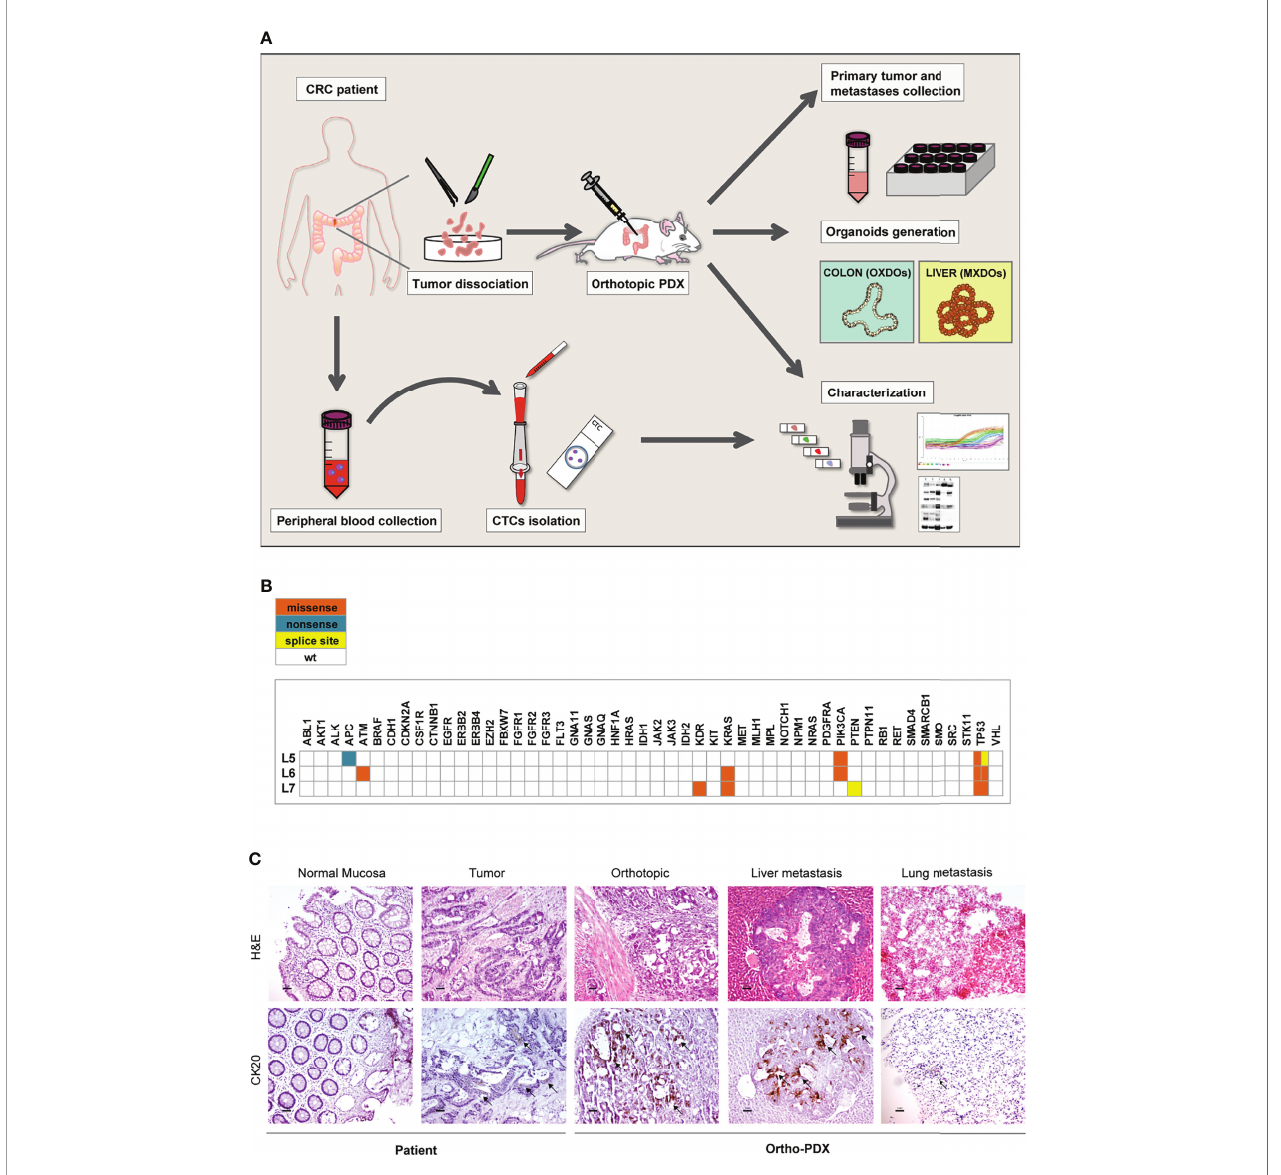
FIGURE 1 | Work fl ow of the orthotopic PDX model. (A) Orthotopic patient-derived xenografts (Ortho-PDX) were directly generated from a colon adenocarcinoma surgically removed from a CRC patient. Dissociated tumor cells were injected in the colon wall of immunocompromised (NSG) mice. Upon tumor formation, intestinal and metastatic tumor tissues were collected and characterized. Organoid were generated from orthotopic xenografts (orthotopic xenograft-derived organoids, OXDOs) and from liver metastases (metastatic xenograft-derived organoids, MXDOs). Circulating tumor cells (CTCs) were collected from patients ’ peripheral blood, counted and analyzed for marker expression. (B) Distribution of functionally relevant variants found among the 50 genes included in the Ion AmpliSeq Cancer Hotspot Panel v2 panel, in the 3 samples under study. Missense, nonsense and splice site variants are depicted in orange, blue and yellow, respectively. (C) Paraf fi n- embedded sections of normal mucosa, patient tumor, orthotopic tumor, liver and lung metastases were stained with Hematoxylin/Eosin (H&E, upper panels) and cytokeratin-20 (CK20, lower panels). Magni fi cation 20x. Bar 50 m